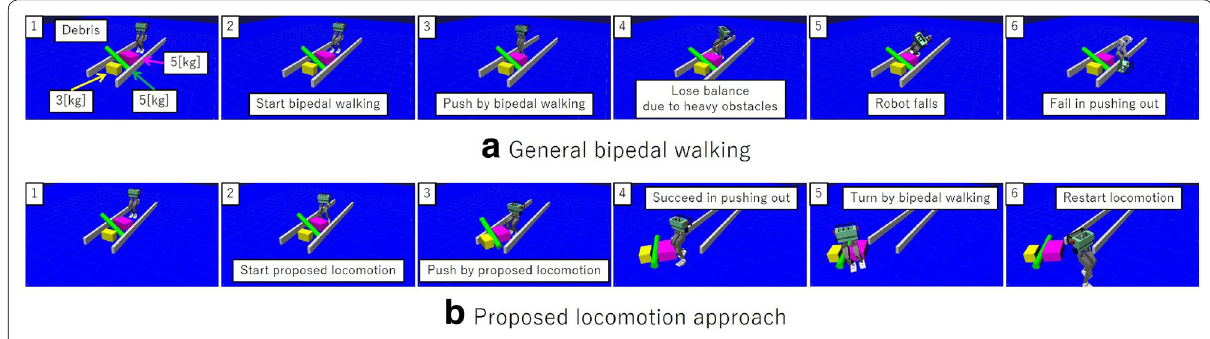
Fig. 15 Locomotion tasks with pushing obstacles out in debris